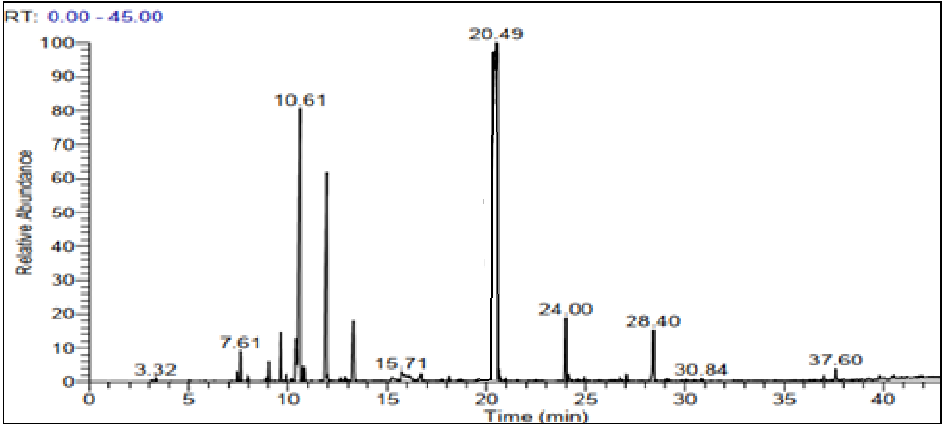
Figure 1. Chromatogram of the O. elongatum EO. Table 1. Chemical composition of the EO of O. elongatum from